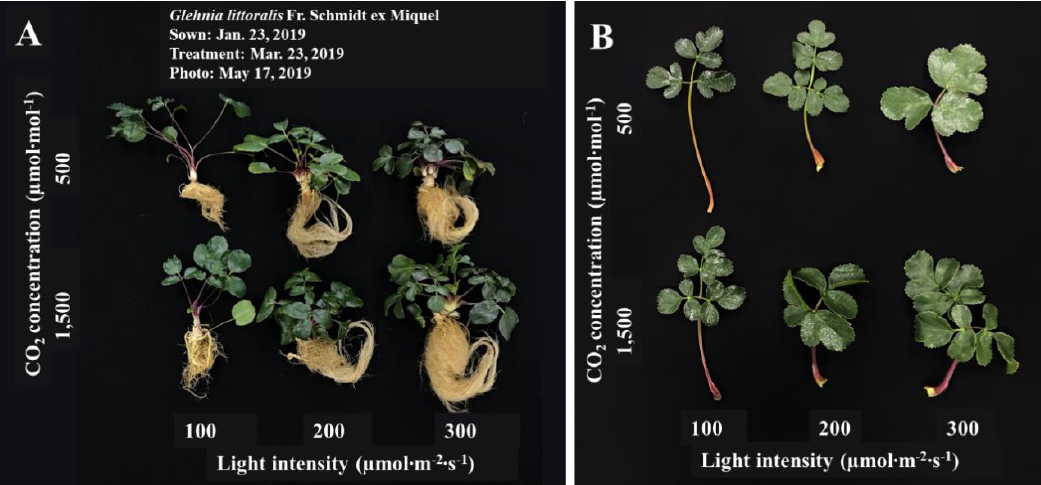
Figure 1. Images of the growth of the whole plant ( A ) and leaf ( B ) of Glehnia littoralis Fr. Schmidt ex Miquel as affected by different CO 2 concentrations and light intensities. Table 1. The different shoot growth characteristics of Glehnia littoralis Fr. Schmidt ex Miquel, as affected by various CO 2 concentrations and light intensities after 56 days of treatment ( n = 3).